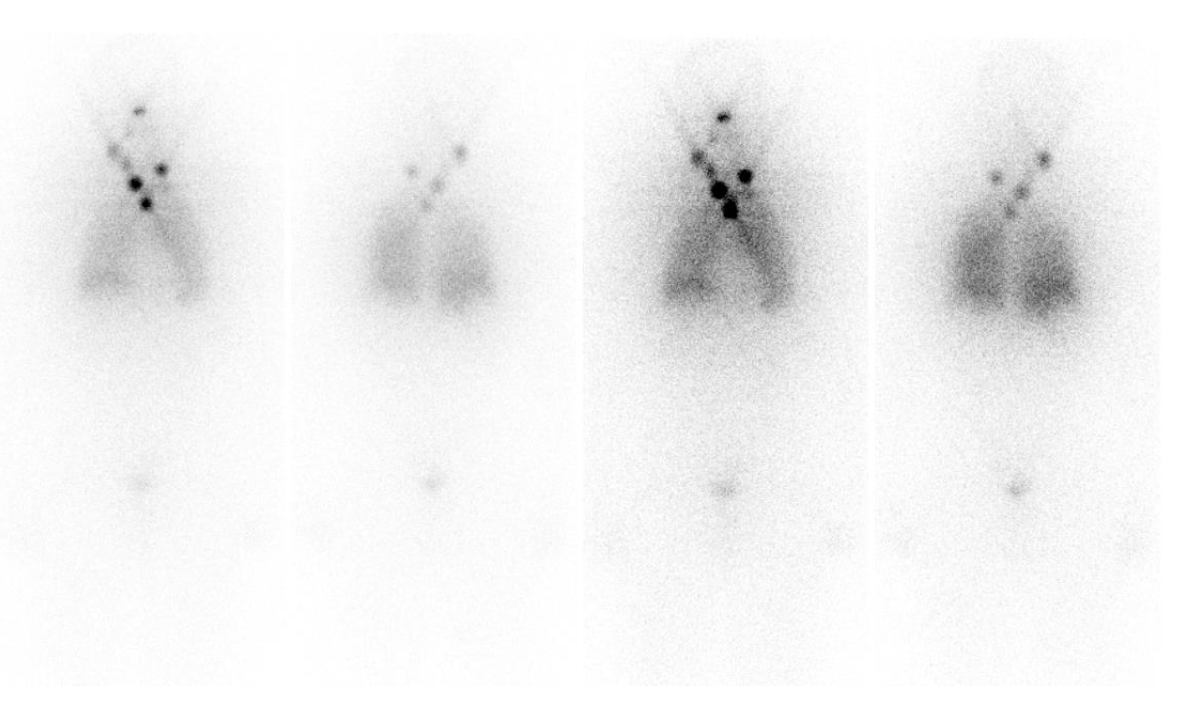
Figure 3. Post-treatment high-activity 131 I whole-body scintigraphy. Multiple cervical and mediasti- Figure 3. Post ‐ treatment high ‐ activity 131 I whole ‐ body scintigraphy. Multiple cervical and mediasti ‐ nal iodine-avid metastatic lymph nodes and diffuse lung “miliariform” nal iodine ‐ avid metastatic lymph nodes and diffuse lung “miliariform” metastases.